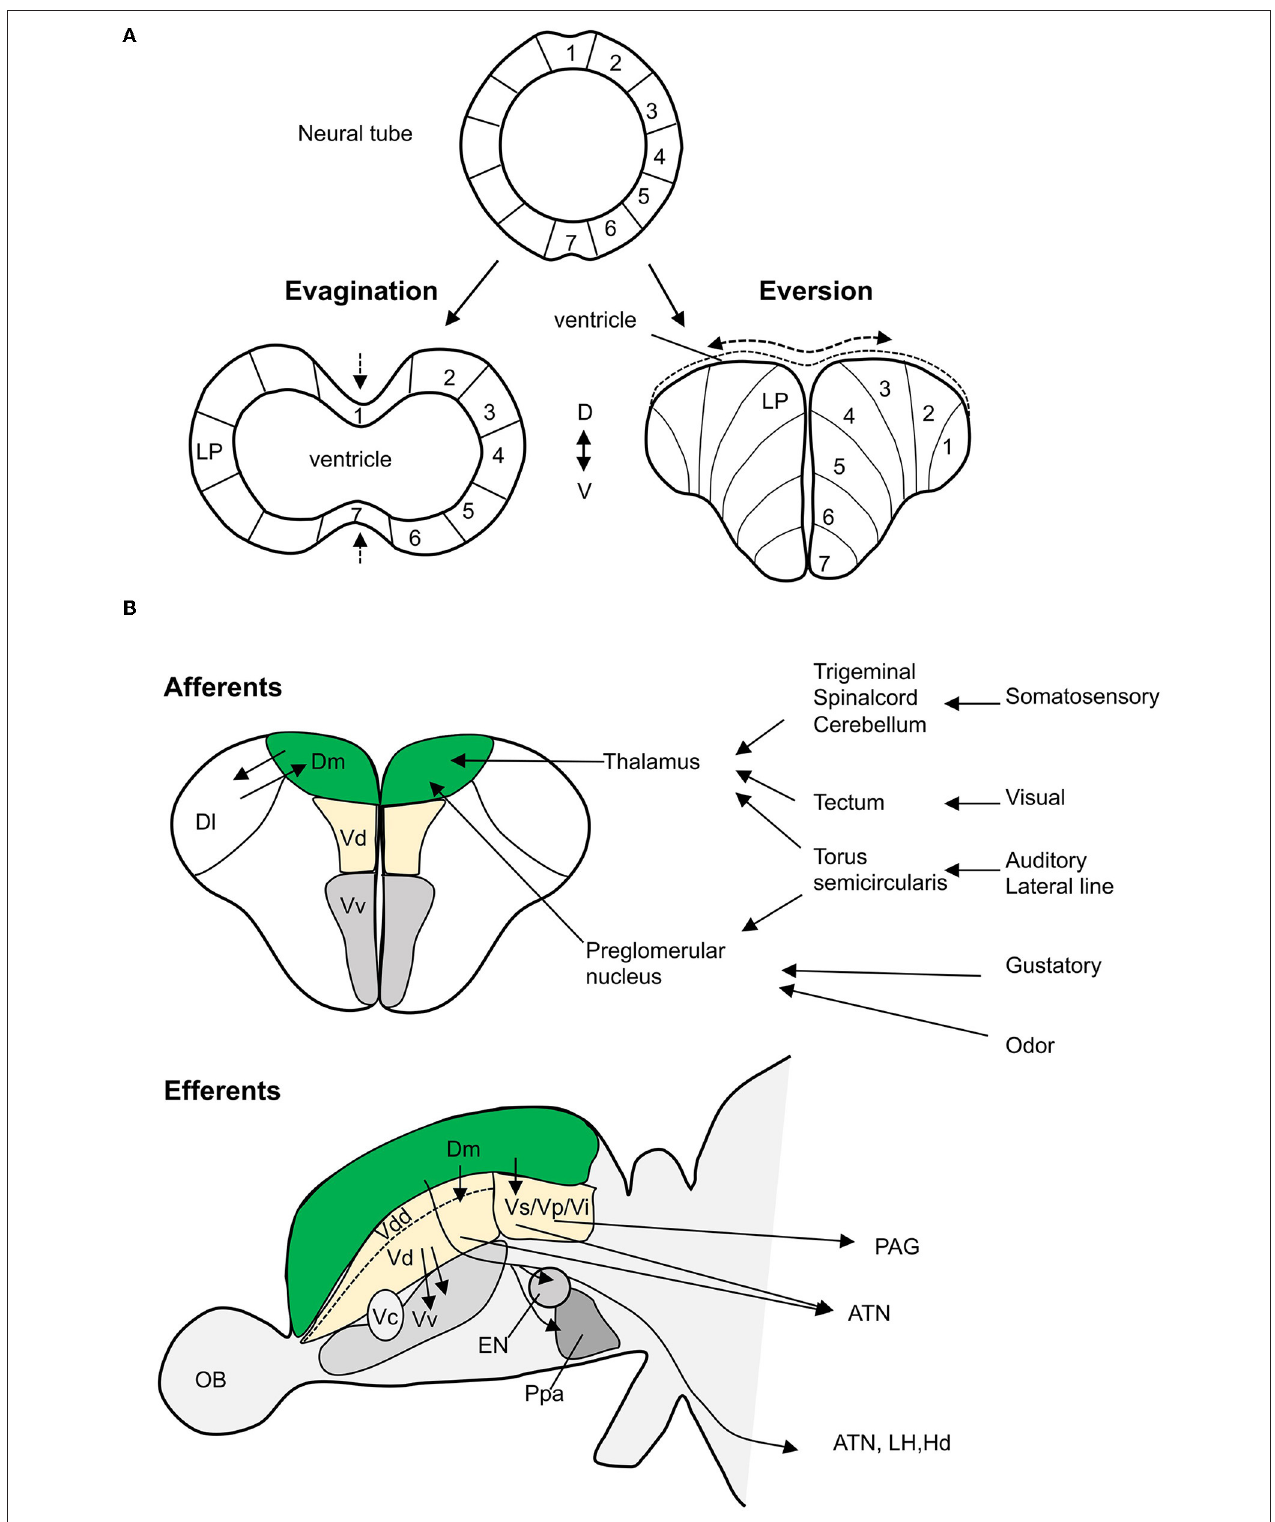
FIGURE 1 | Teleost amygdala. (A) The development of telencephalon from neural tube (top) comparing evagination (in mammals) vs . eversion (in teleosts). In mammals, the lateral pallium (LP), putative amygdala region, lies laterally, whereas in teleosts, in a simple eversion, the corresponding structure lies medially. (B) The main neural connectivity of the teleost amygdala complex. Teleost Dm receives sensory information (somatosensory, visual, auditory, lateral line, gustatory, and odor)